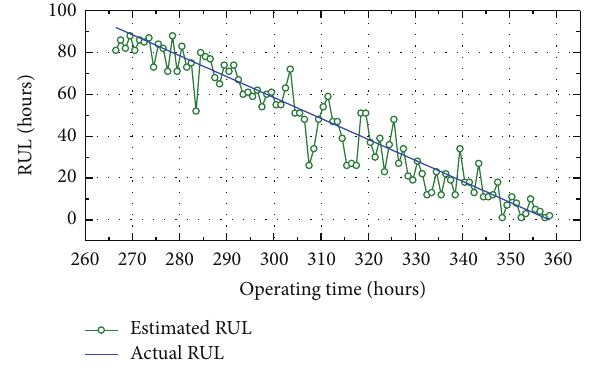
Figure 15: RUL estimation for the inner-race-fault case based on PSS.